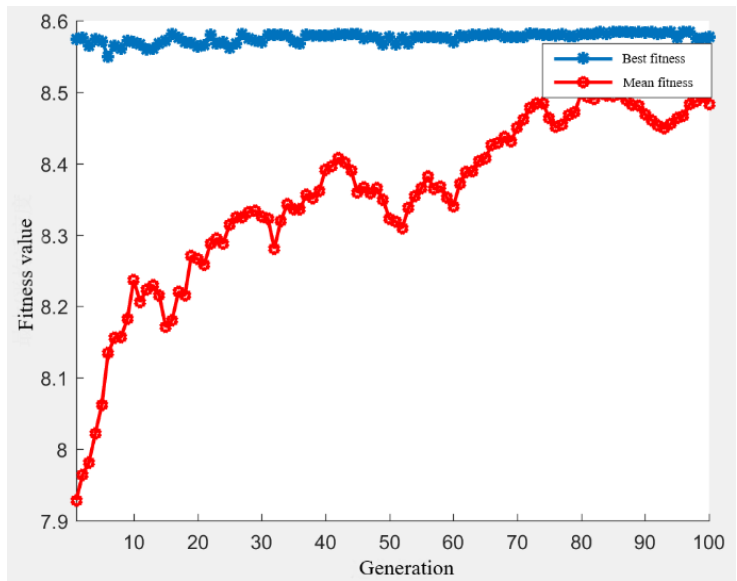
Figure 4. Convergence trend of the solution algorithm for mixed scheduling model.